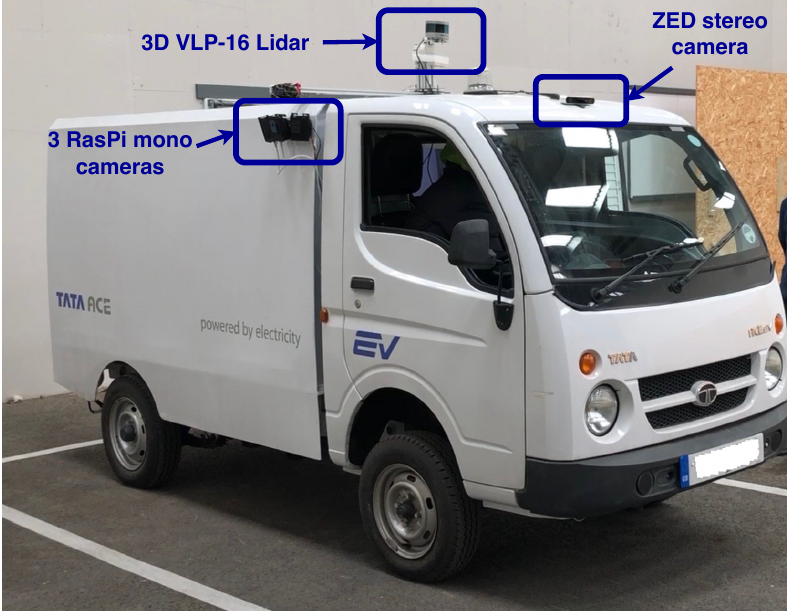
Figure 3. Our electric testbed showing the hardware and sensor